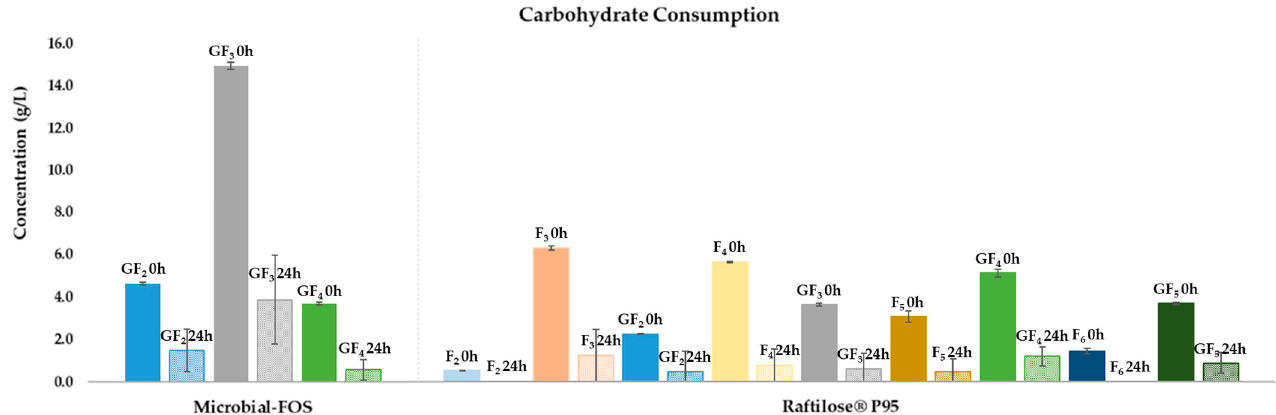
Figure 1. Carbohydrate profiles of microbial-fructo-oligosaccharides (Microbial-FOS) and Raftilose ® P95, before and after 24 h fermentation with fecal microbiota from five donors. Values are expressed as mean ± SD. GF 2 —1-kestose, GF 3 —nystose, GF 4 —fructo-furanosylnystose, F n (2 < n < 6)—FOS.